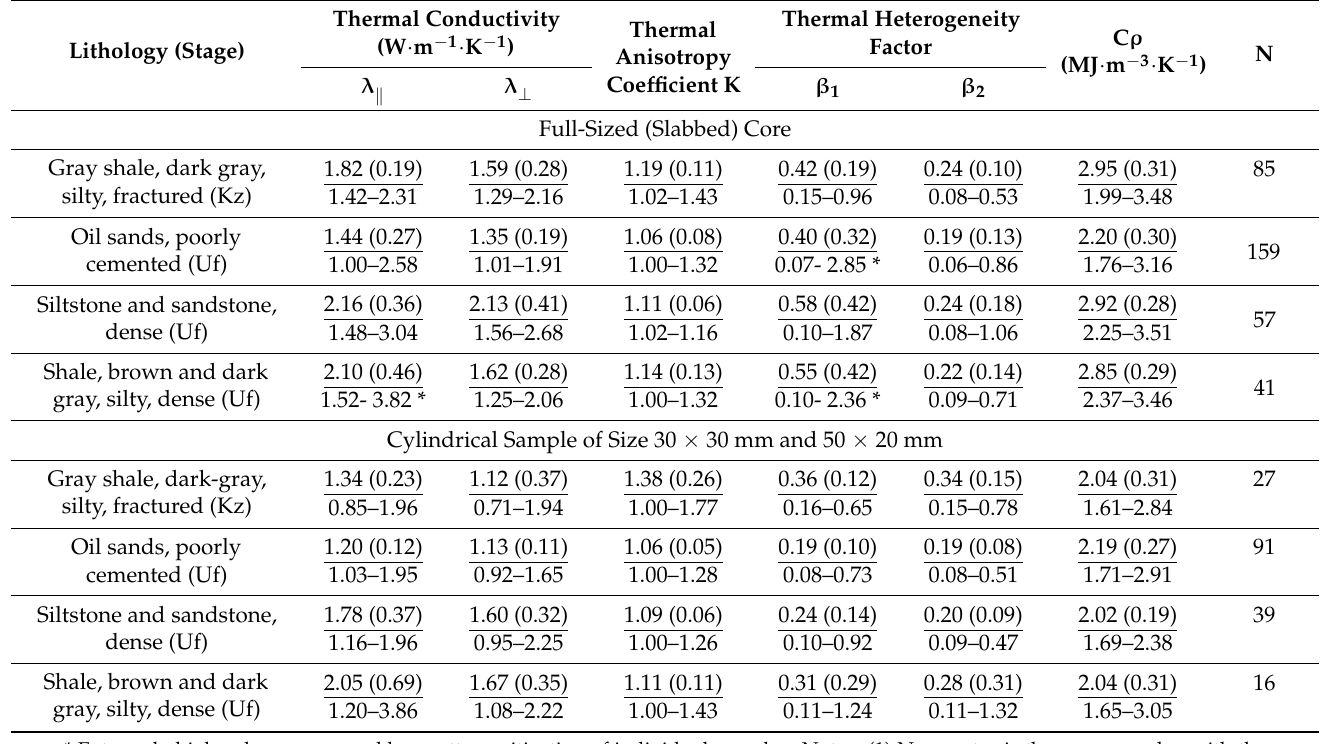
Table 3. Statistical characteristics of rock thermal properties experimentally